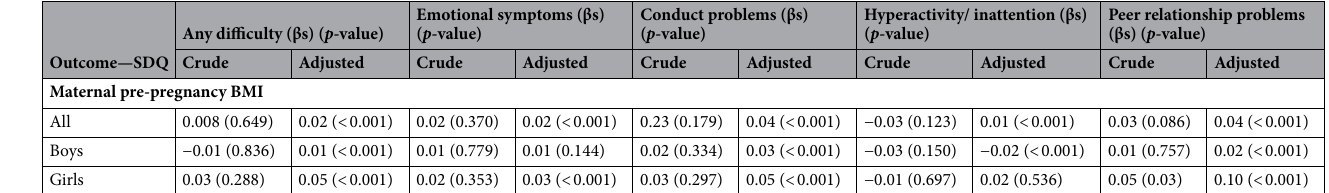
Table 3. Linear regression associations between maternal pre-pregnancy body mass index (BMI) and children’s mental problems at 11 years of age. a Adjusted for child’s sex, maternal age, skin color, parity, maternal schooling, family income and smoking during pregnancy (child´s sex was removed when appropriated). p -value: Prob >